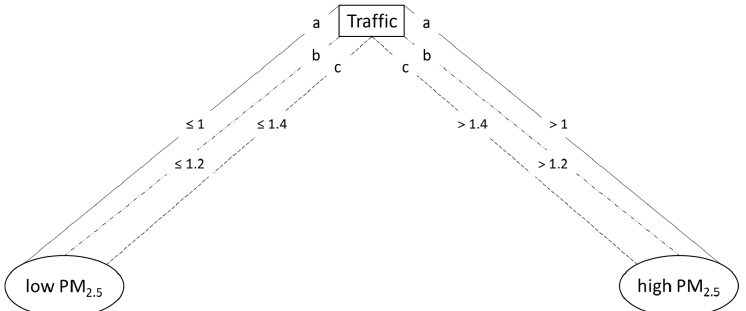
Figure 7. Decision tree models to predict the PM 2.5 pollution levels (high vs. low) according to the